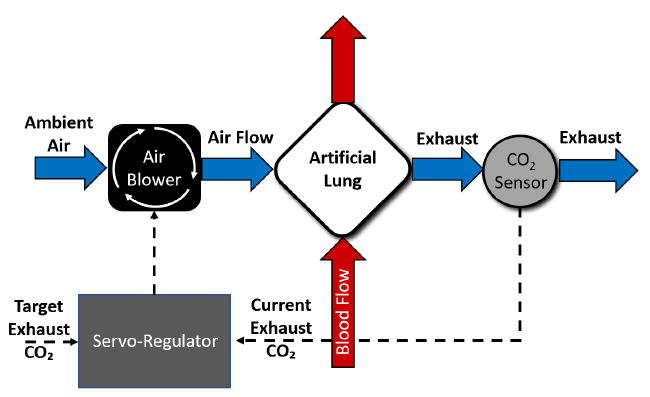
Figure 1. An overview of servoregulation-based sweep gas control.